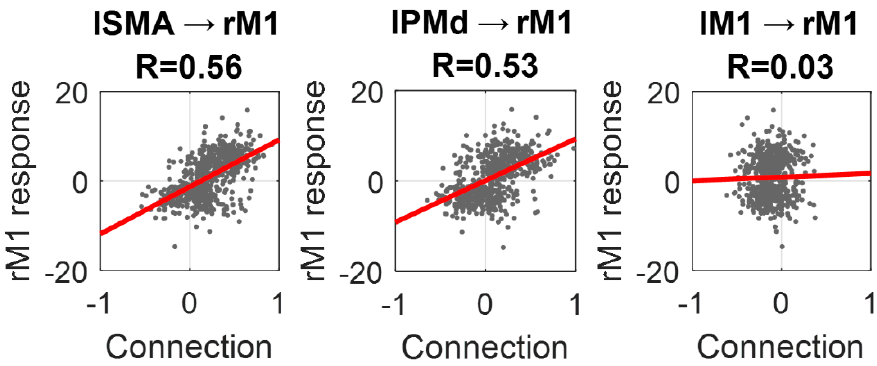
Figure 8. Correlation of key inter-hemispheric connections and rM1 response. In each plot, the dots are individual subjects. The horizontal axis is the posterior expected value from the individual subjects’ DCM and the vertical axis is the amplitude of the response in rM1 from the SPM analysis. The line of best fit is in red. Pearson’s correlation coefficients are provided in the titles.